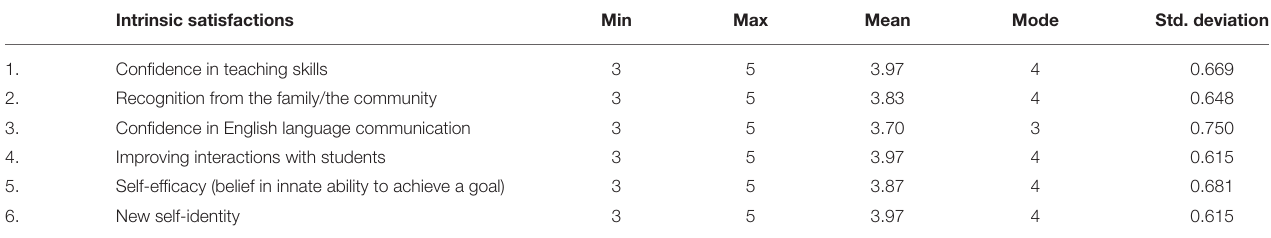
TABLE 4 | Descriptive analysis for the level of teacher’s intrinsic